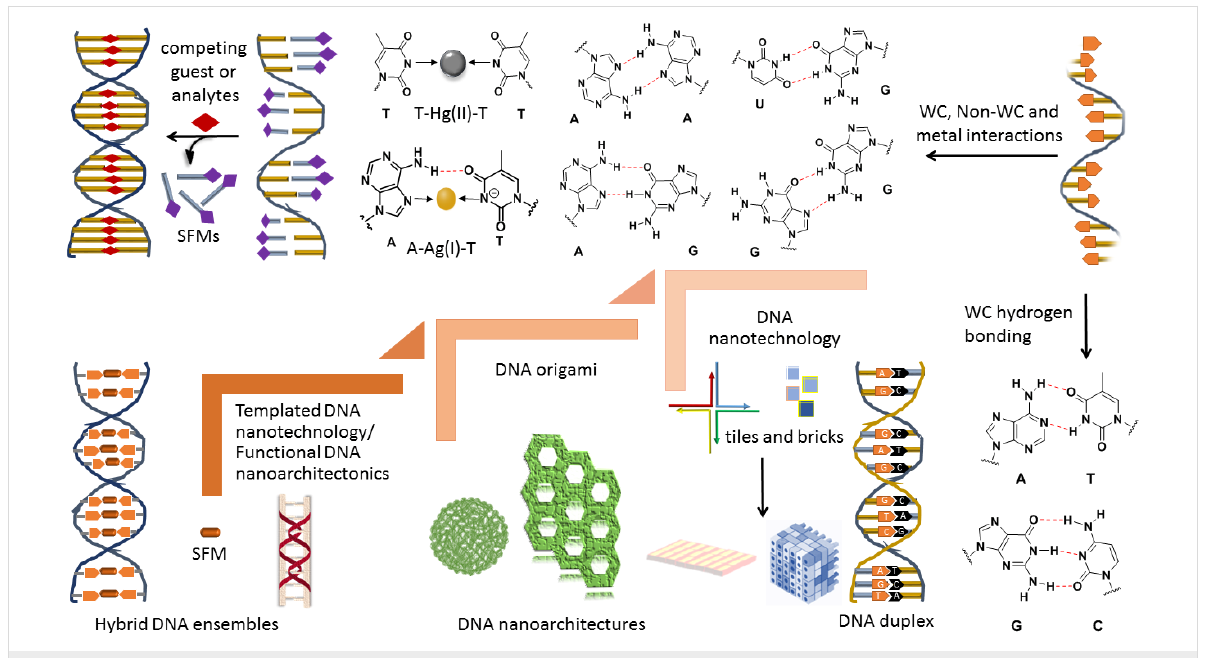
Figure 1: Illustration of conventional (WC) and unconventional (non-WC) hydrogen bonding interactions between the nucleobases to form canonical (DNA duplex) and noncanonical hybrid DNA ensembles through the assembly of DNA or DNA with SFMs/metal ions. The brick image has been adopted with permission from [17], copyright 2012 American Association for the Advancement of